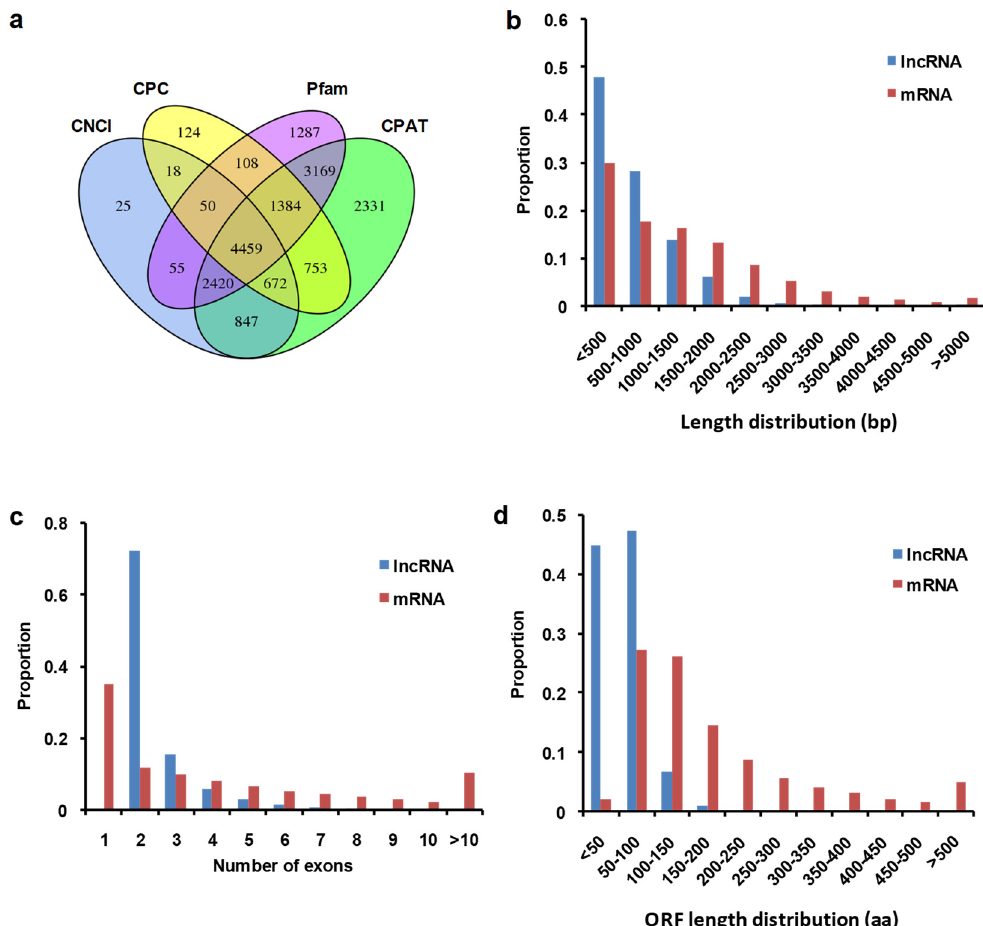
Figure 5. Characteristics of lncRNAs identified in cabbage. ( a ) The 4459 lncRNAs in cabbage were identified by an intersection of results obtained via three softwares CNCI (Coding-Non-Coding Index), CPC (Coding Potential Calculator), CPAT (Coding Potential Assessment Tool) and a protein database Pfam analysis. ( b ) Length distribution (base pair, bp) of lncRNAs and mRNAs. ( c ) Exon number in lncRNAs and mRNAs. ( d ) ORF length in amino acids (aa) of lncRNAs and